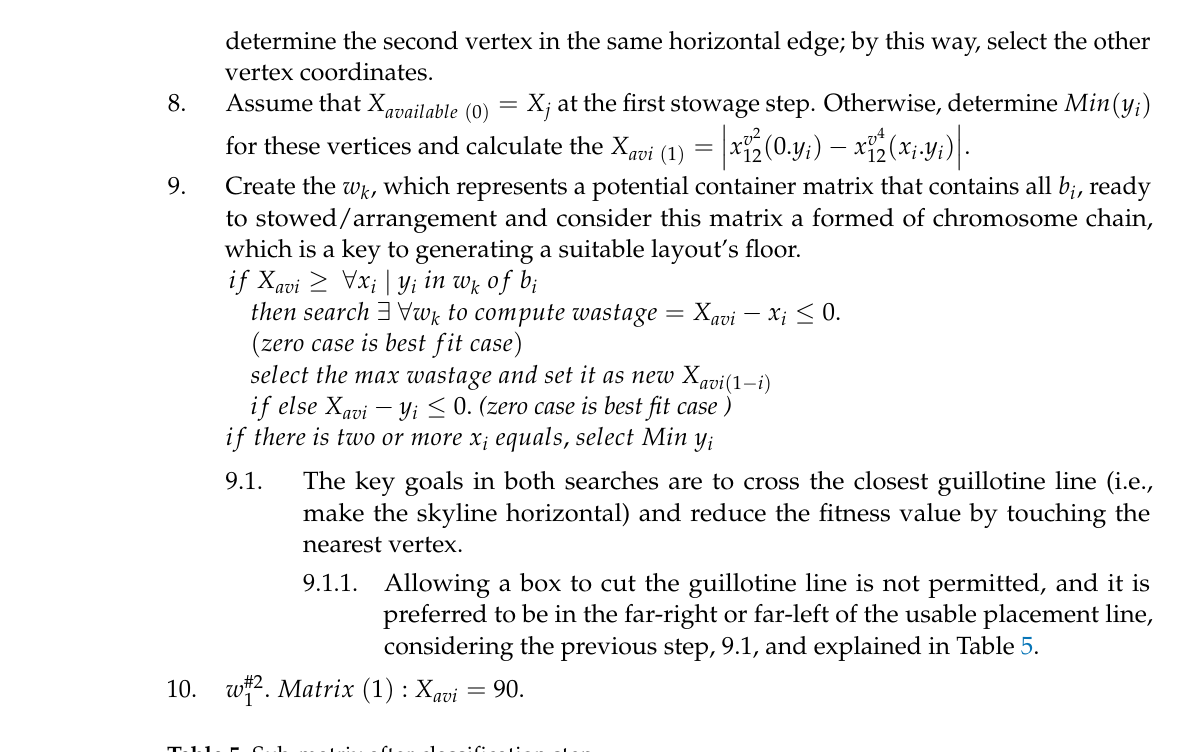
Table 5. Sub-matrix after classification